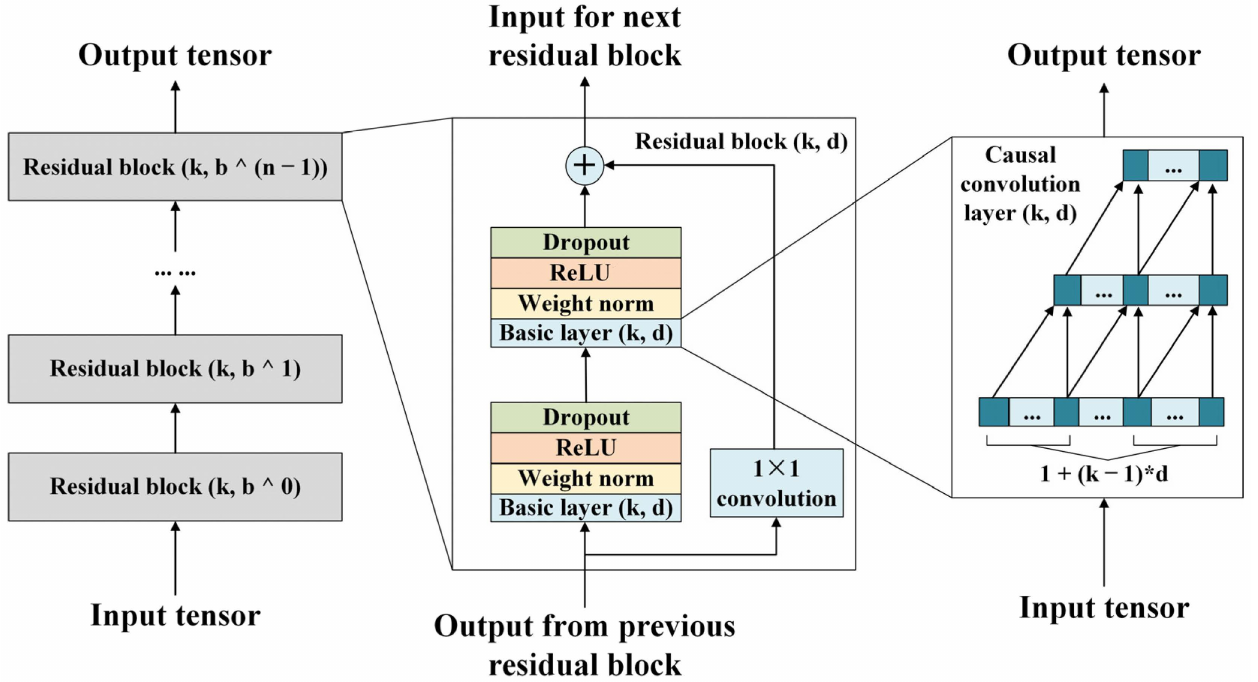
Figure 1. The structural design of the